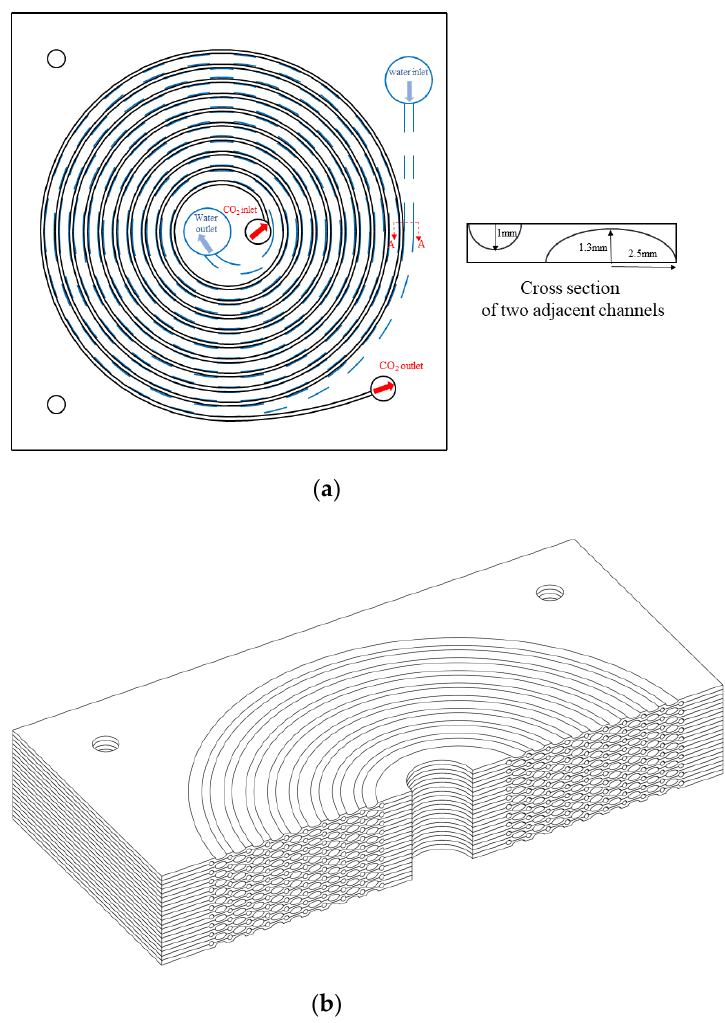
Figure 1. ( a ) A type of structural plate; ( b ) Overall schematic.